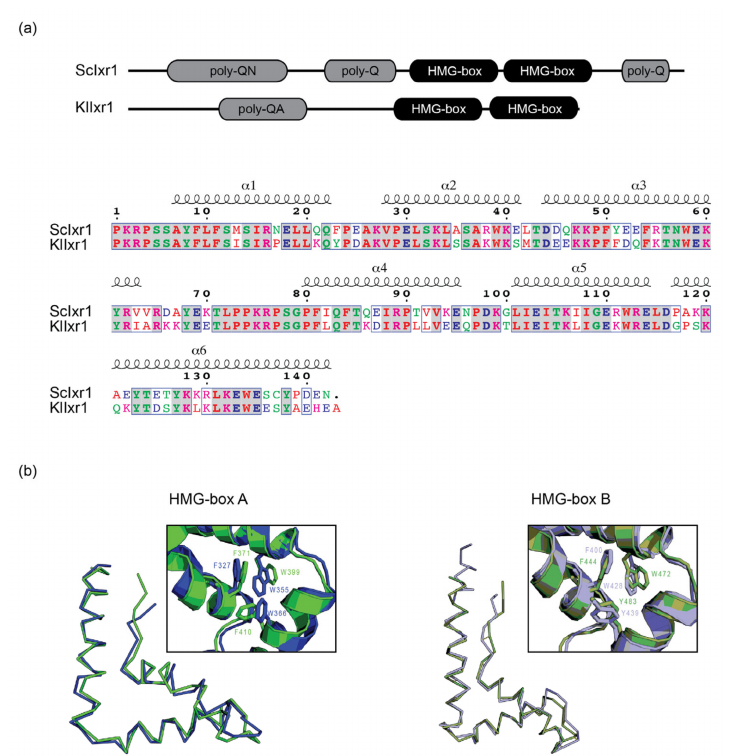
Figure 1. ( a ) In silico comparison of Ixr1 amino acid sequence from S. cerevisiae and K. lactis .(upper) Scheme of protein domain distribution in Ixr1 protein from S. cerevisiae and K. lactis. (lower) Pairwise alignment of the Ixr1 double HMG-box domains arranged in tandem from S. cerevisiae (Uniprot code P33417 ) and K. lactis (Uniprot code Q6CMQ4 ). Conserved amino acids are highlighted in bold and conserved regions indicated by grey boxes. Small and hydrophobic amino acids (less tyrosine) are indicated in red, acidic amino acids in blue, basic amino acids (less histidine) in magenta and hydroxyl + sulfhydryl + amine (STYHCNGQ) in green. ( b ) Model superposition of HMG-box A ( S. cerevisiae in dark green and K. lactis in dark blue) and HMG-box B ( S. cerevisiae in light green and K. lactis in light blue). Enlarged frames show the conserved aromatic residues that form the cluster stabilizing the three-helix HMG